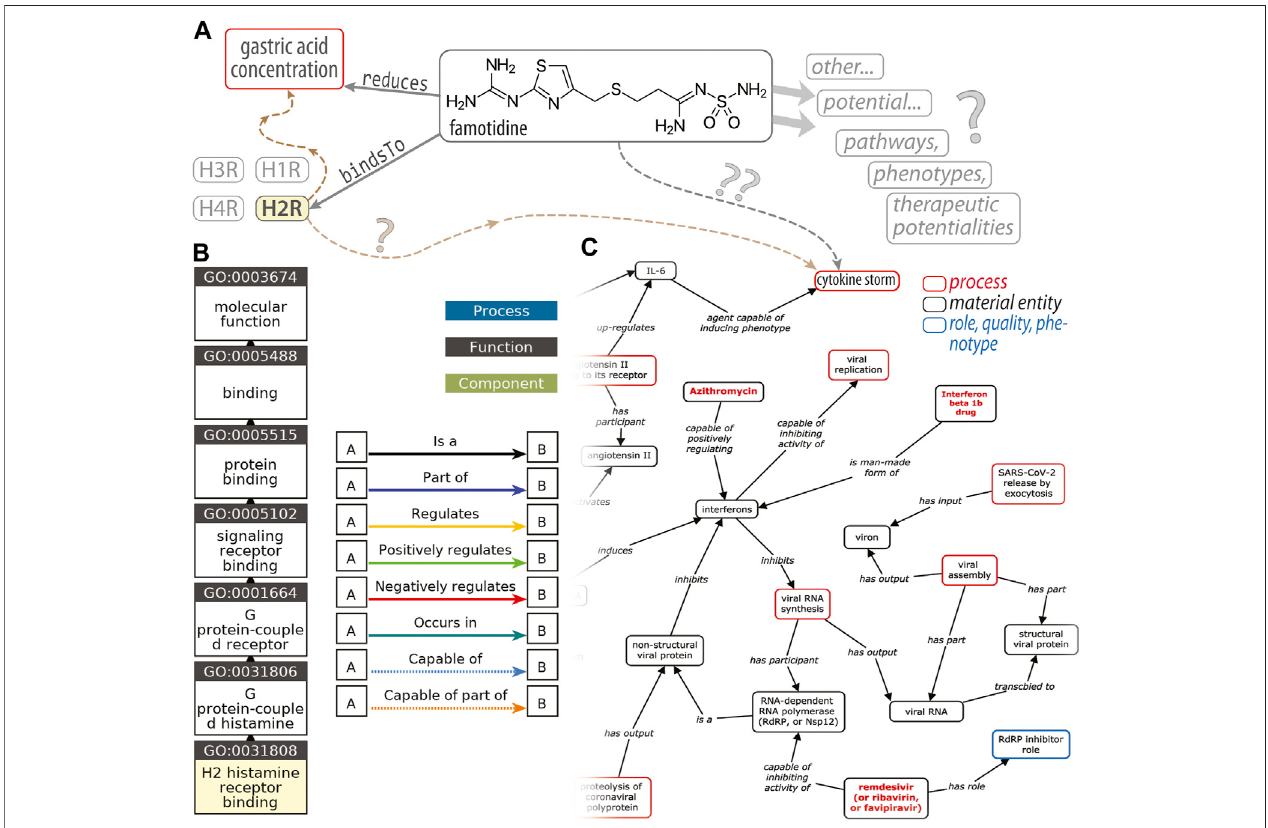
FIGURE 1 | An ontological perspective on famotidine and COVID-19. This diagram (A) illustrates the types of RDF triple associations, consisting of a ( subject, predicate, object ) triplet, that express the relations between entities that underlie an ontology. In this simpli fi ed example, one such triple would be (famotidine, bindsTo , H2R) (histamine type-2 receptor) and another is (famotidine, reduces , gastric acid concentration); H1R, H3R and H4R denote other subtypes of histamine receptors.Thebrowndashedarrows(at left )areplaceholderstosignifytheH2R-triggeredsignalingcascadesthatultimatelymodulategastricacidlevels.Question marks ( “ ? ” ) decorate linkages where our knowledge is either quite tenuous or vague. The GO “ ancestor chart ” , in (B) , illustrates a concept hierarchy for the term GO: 0031808,correspondingtoaparticular molecularfunction named “ H2histaminereceptorbinding ” ;traversingthisconcept/classhierarchy,fromtheleaf (bottom) tothe root(top; “ molecularfunction ” ),correspondstoatraversalofsuccessivelybroadercategoriesofconcepts/classes[e.g.,theH2R is_a typeof(i.e.,asubsetof)GPCRs]. Panel (C) , adapted from Liu et al. (2021), isan excerpt ofa KG ofhost – coronavirus drug/interactions, including at the upper-right aputativelink between famotidineand the cytokine storm.